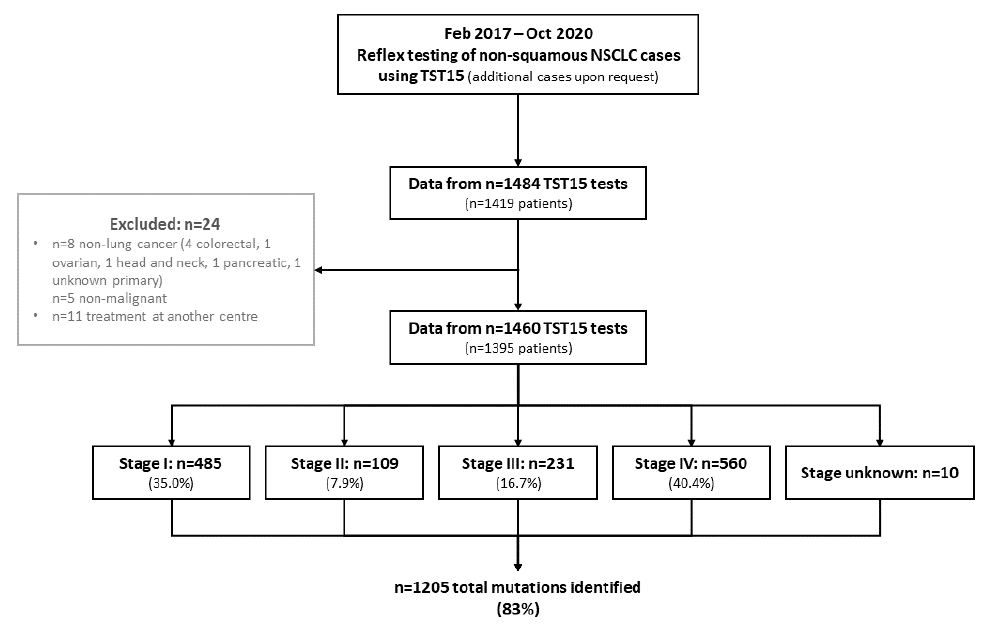
Figure 1. Study flow diagram.